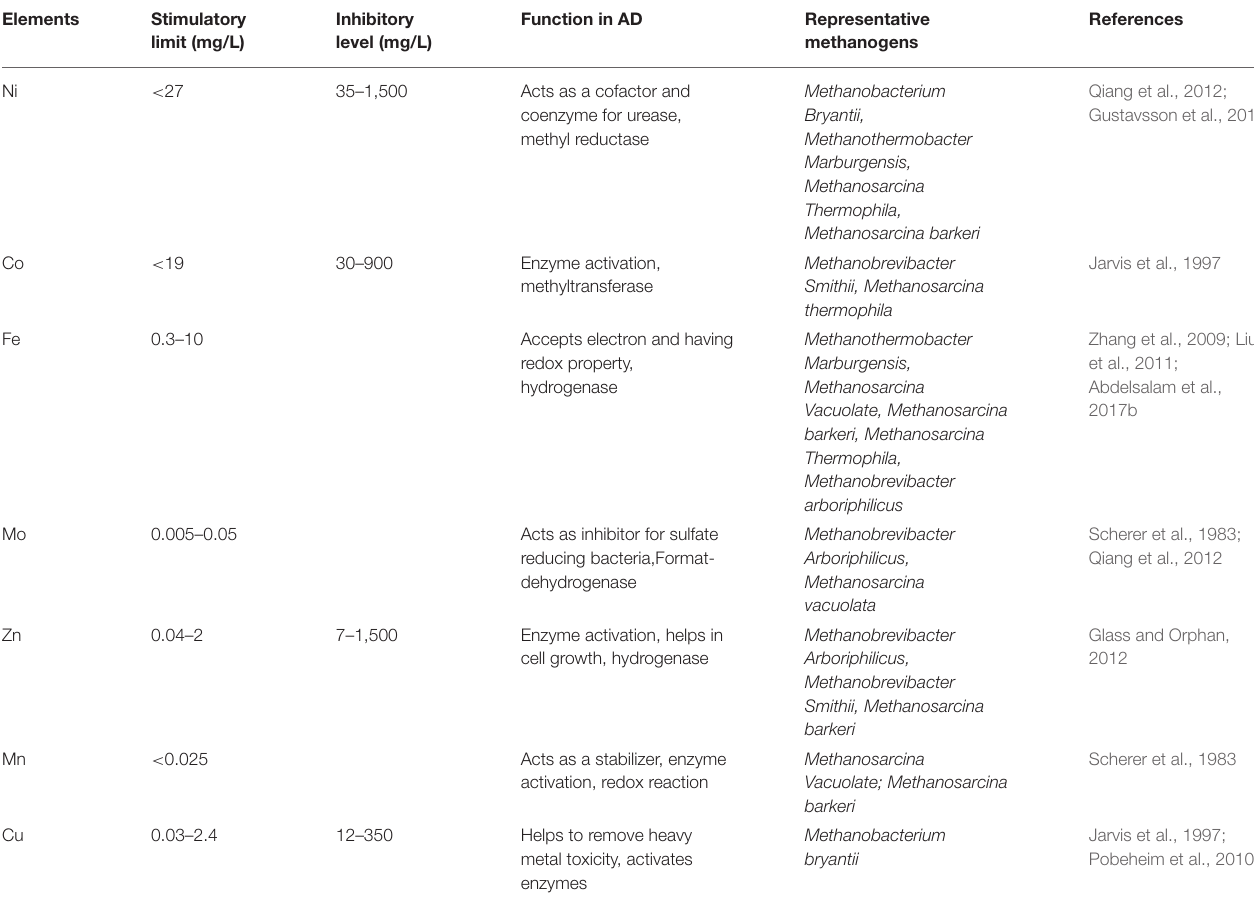
TABLE 3 | Required concentration of trace elements in anaerobic digestion and their function.